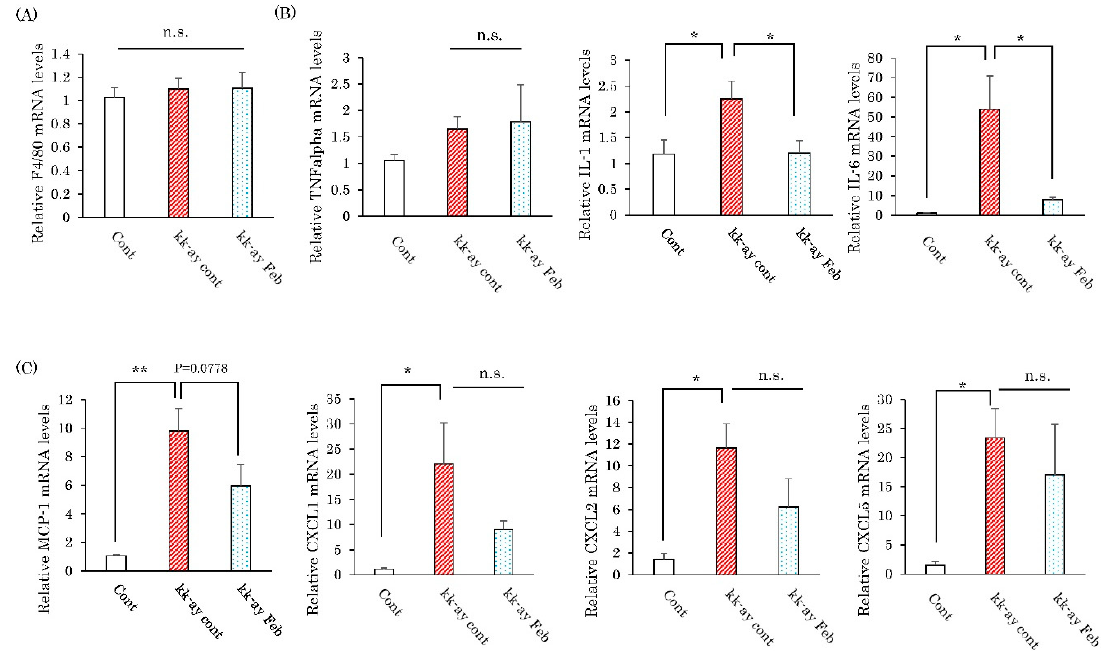
Figure 3. Febuxostat suppressed expressions of inflammatory cytokines in the kidneys of KK-Ay mice. ( A – C ) Relative mRNA levels of macrophage markers, cytokines, and chemokines in the kidneys were determined by employing real-time PCR. Data are means ± SE. * p < 0.05, ** p < 0.001. n = 8 for control group, n = 10 for KK-Ay mice without febuxostat group and n = 8 for KK-Ay mice with febuxostat group.